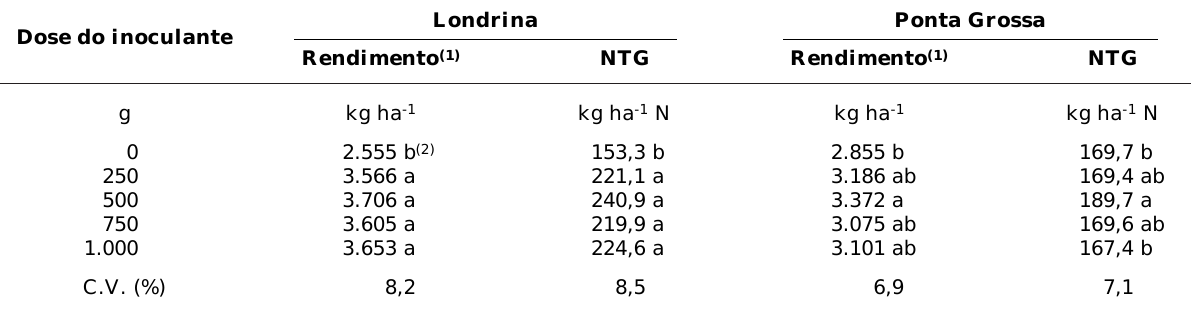
Quadro 6. Efeito de doses do inoculante turfoso (g de inoculante/50 kg de sementes), utilizando as estirpes SEMIA 587 e 5019 (10 8 células/g de inoculante), no rendimento e N total dos grãos (NTG) de soja, cultivar BR-37. Experimentos realizados na safra 1995/1996, em Londrina, em um LR com população naturalizada (10 5 células de Bradyrhizobium /g de solo), e em Ponta Grossa, em um LVe com população naturalizada (10 3 células de Bradyrhizobium /g de solo). Como aderente, foram utilizados 500 ml/50 kg da solução açucarada a